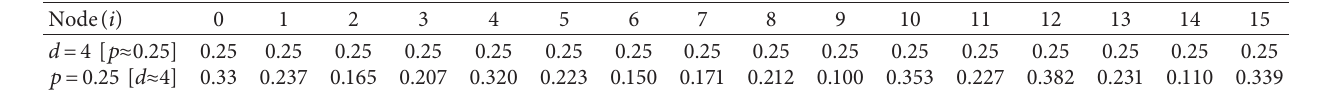
Figure 5: Prototype of a random network with its properties. The number of nodes n � 16; connection probability p � 0 . 937 (b) and p � 0 . 25 (a). The plot on the left-hand side of each half of the figure shows the random (Erd¨os–R´enyi) network that was created. Each node is represented by a circle, with an arbitrarily assigned label from 0 to 15, and each line represents a link. The plot on the right-hand side of each section shows the adjacency matrix with entries in row m and column n (either 1 (black) or 0 (white)). Table 5: Numerical result for eigenvector_centrality [ Ax � λ x ].